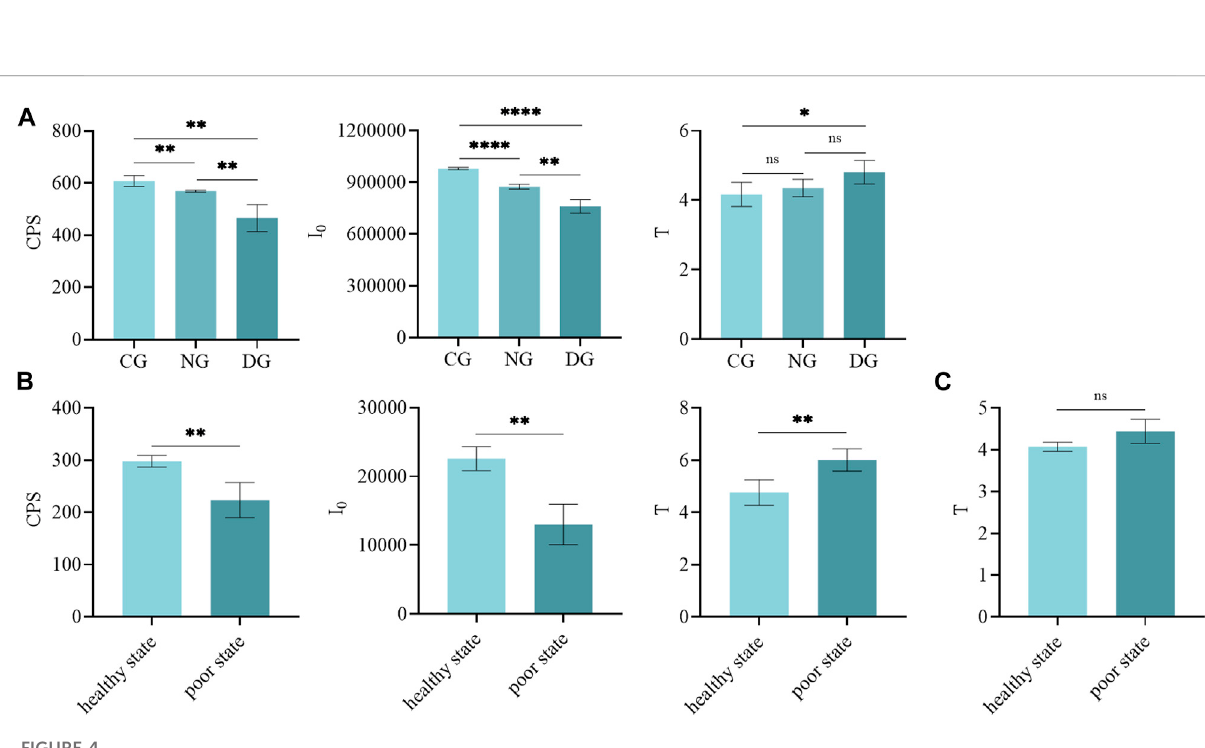
The t-test in biophoton parameters of motherwort and saf fl ower in different growth states. (A) Motherwort. (B) Saf fl ower. (C) Saf fl ower